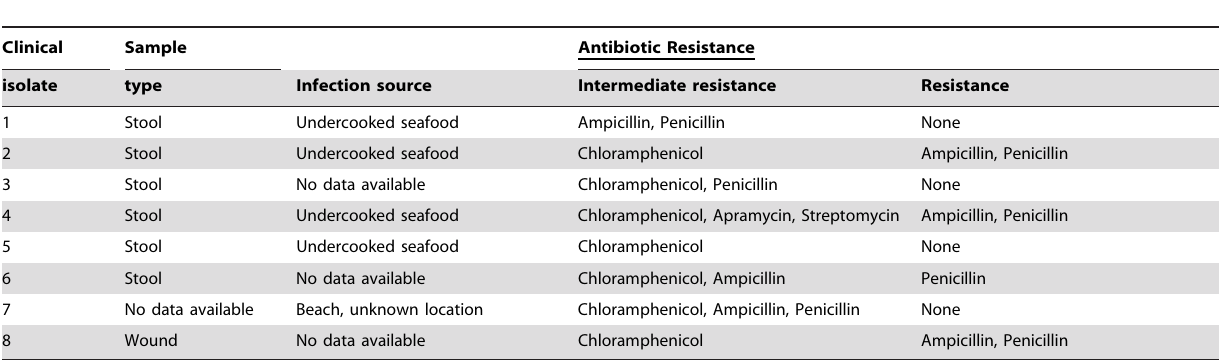
Table 2. Sample type, infection source, and antimicrobial resistance of clinical V. parahaemolyticus isolates provided by the Maryland Department of Health and Mental